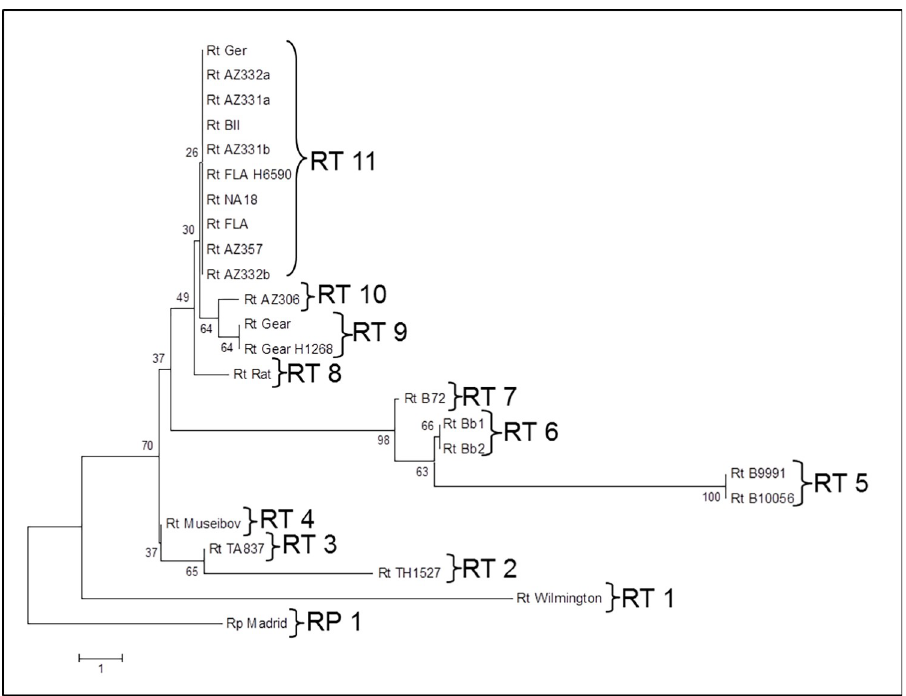
Fig 4. Neighbor joining tree analysis of the variant genetic sites found in isolates of R . typhi . Clades obtained by combining the SNP and INDEL site data. Bootstrap values are shown on the nodes.